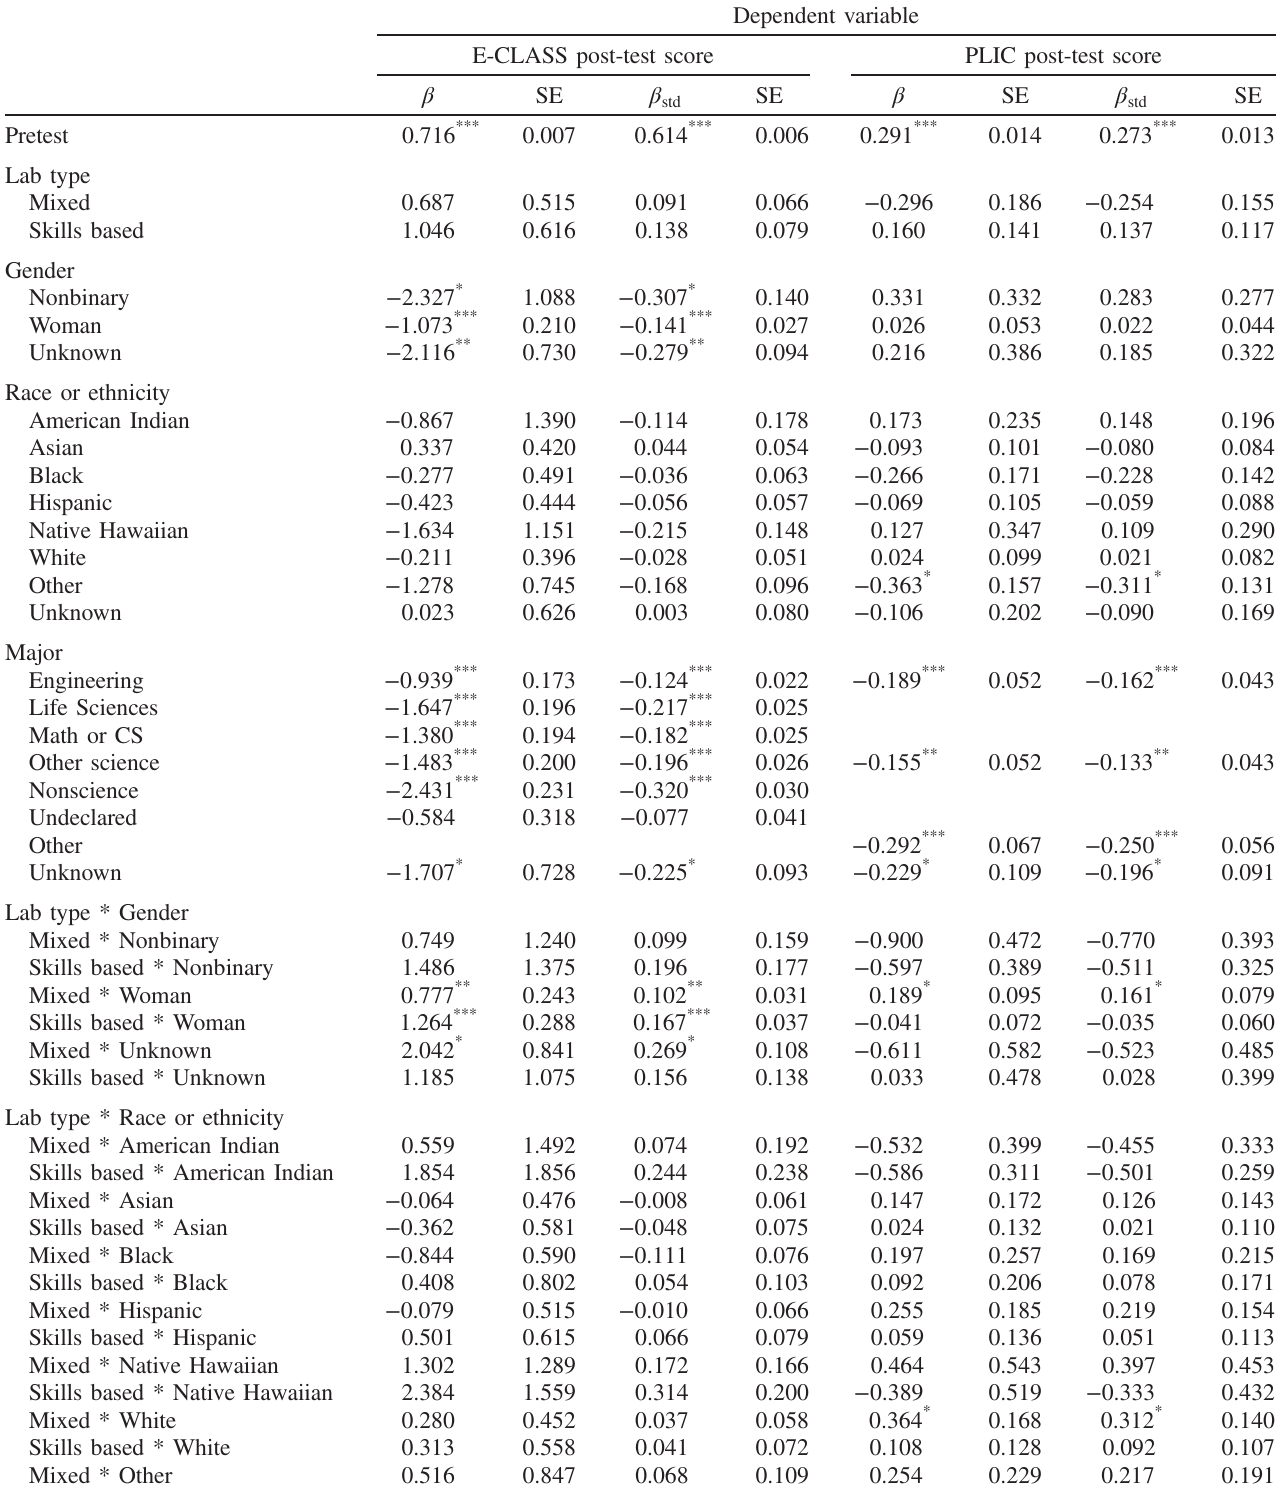
TABLE V. Two-level linear mixed models of E-CLASS and PLIC post-test scores including lab type and demographic variables with institutions as random intercepts. Standardized coefficients represent effects with pretest and post-test scores grand mean centered. Effects for nominal variables are relative to the reference level (variable level not shown). The variance explained by the fixed effects and random effects (fixed effects alone) is 44% (42%) for E-CLASS and 16% (10%) for